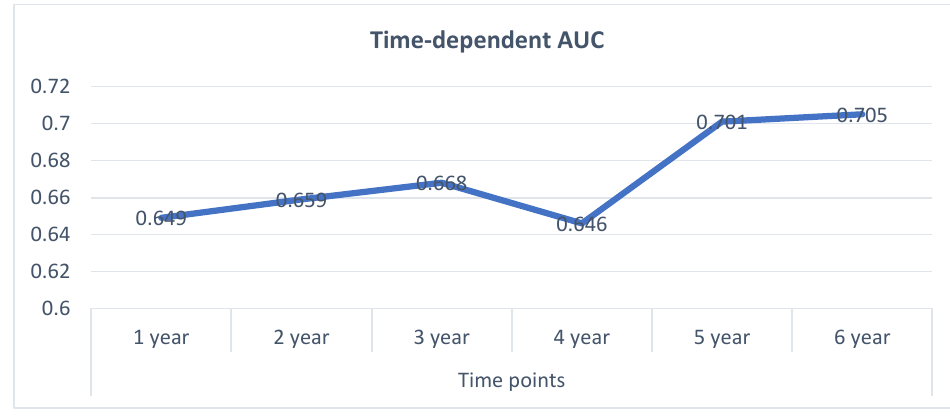
Figure 3. Time-dependent AUC values for internal nomogram validation.